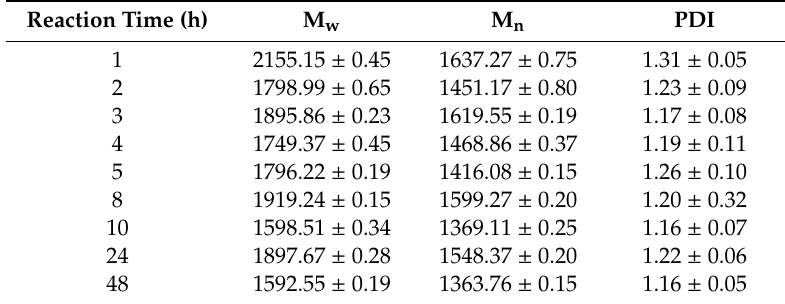
Table2. M w , M n andPDI(Mw / Mn)Valuesforcopolymerizationof ω -carboxyloxoPAand1,8-octanediol using Novozyme 435.